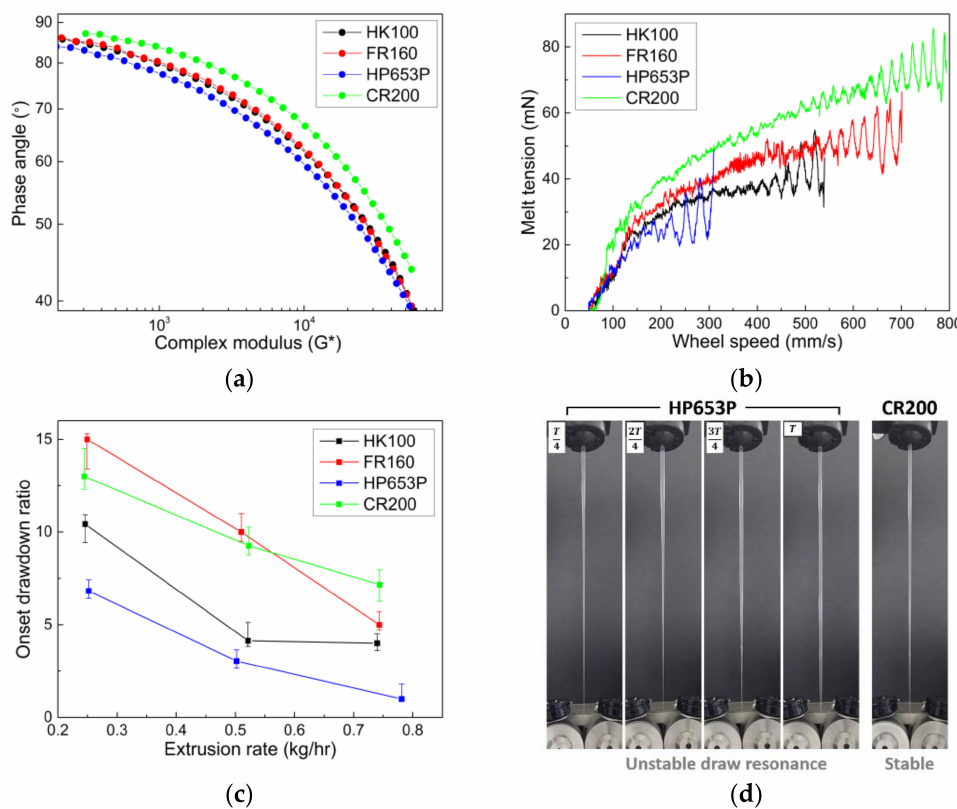
Figure 10. Comparison of ( a ) van Gurp–Palmen plot, ( b ) melt tension, and ( c ) draw resonance onset of CR-PP (CR200) and homo PPs (HK100, FR160, and HP653P) in melt-spinning process. ( d ) Fiber formations from the spinneret to take-up for HP653P (unstable state) and CR200 (stable state) under conditions of drawdown ratio of 8 and extrusion rate of 0.5 kg/h. T is the period of